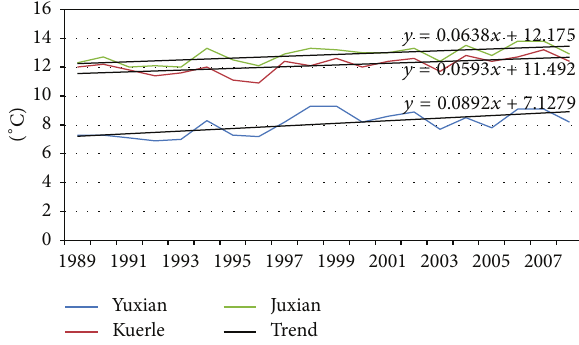
Figure 8: Temperature recorded at the selected weather stations from 1989 to 2008.